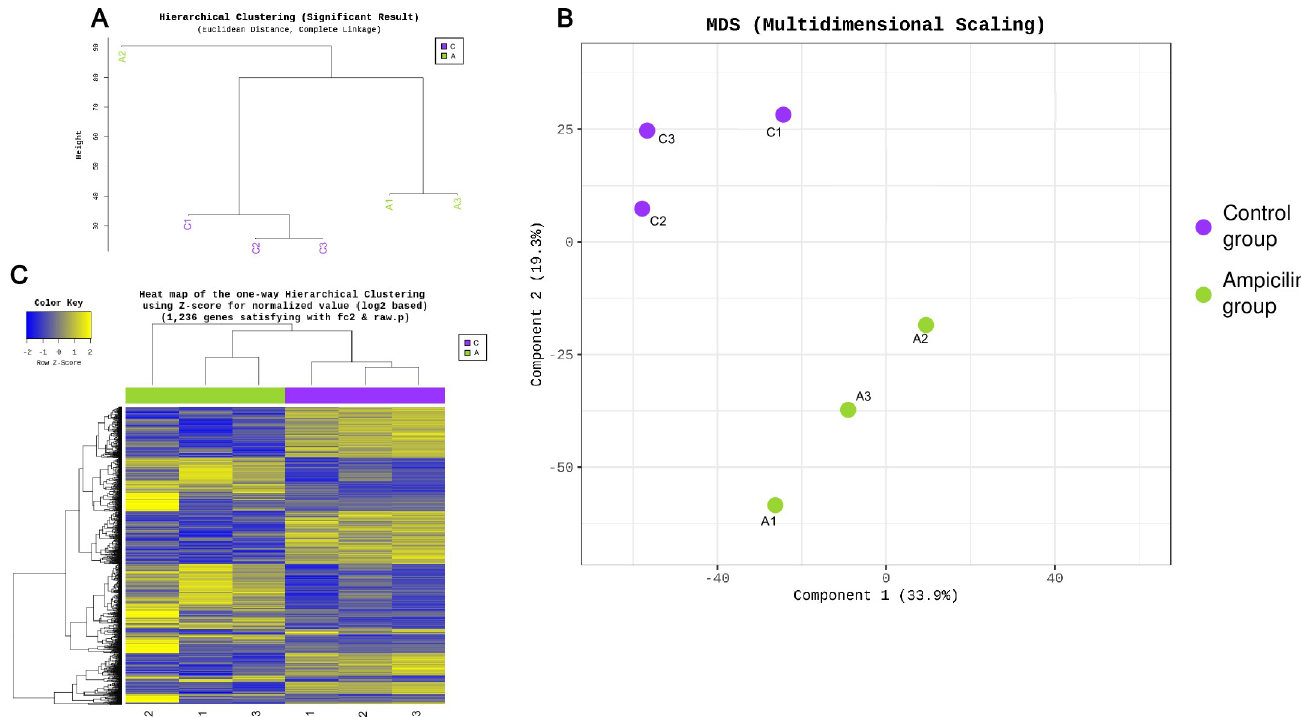
Fig 5. Transcriptome analysis in ampicillin-treated and control cockroaches. (A) UPGMA (unweighted pair group method with arithmetic mean) clustering. (B) Principal components analysis depicting the differences in the differentially expressed genes (DEGs) between the control and ampicillin-treated groups. (C) Heat map of transcriptional expression patterns of the two groups, displaying the expression profile of the top 1,236 DEGs for each sample in the RNA-seq dataset.